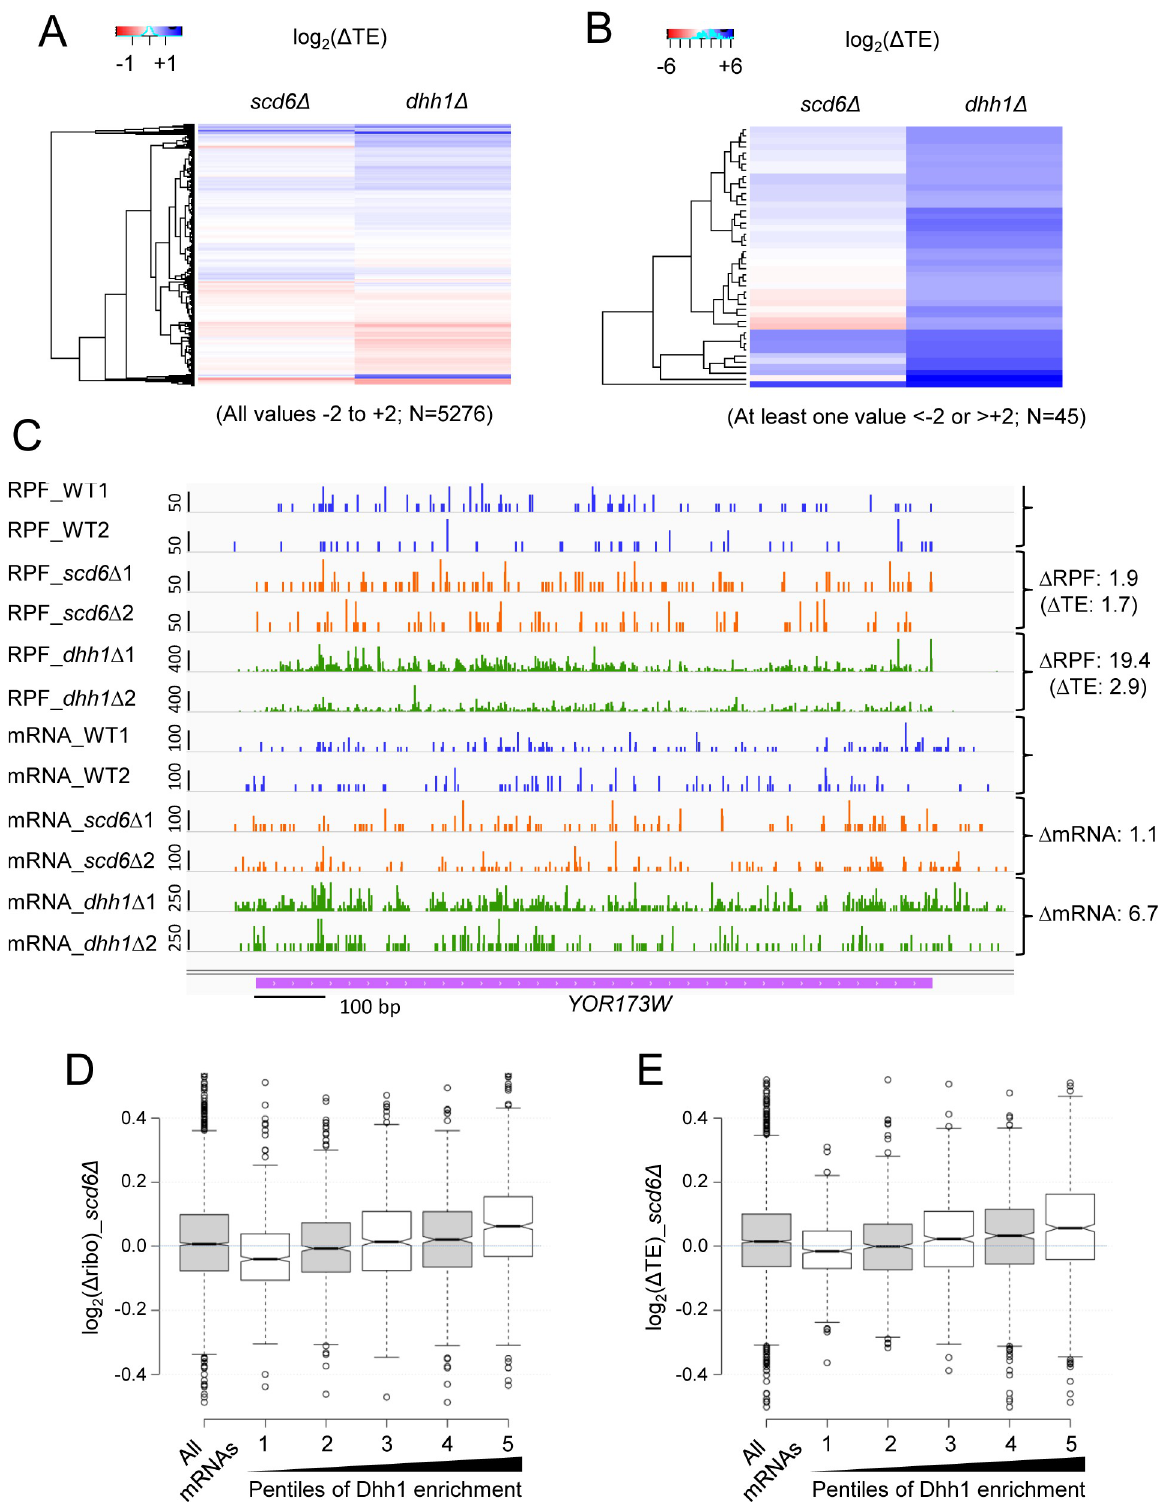
Fig 8. Scd6 and Dhh1 cooperate in repressing translational efficiencies of a subset of native mRNAs in a manner associated with elevated Dhh1 occupancies. (A-B) Hierachical clustering analysis conducted with the R heatmap.2 function from the R gplots library, using the default “hclust” hierarchical clustering algorithm, using ribosome profiling data from scd6 Δ (SYY2353), dhh1 Δ (QZY126, dhh1 Δ (z) ), and WT (HFY114)